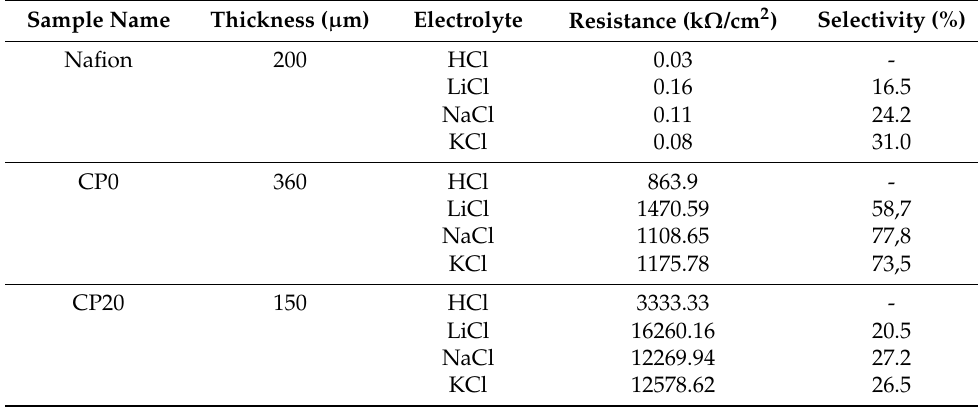
Table 5. A summary of data obtained from LSV